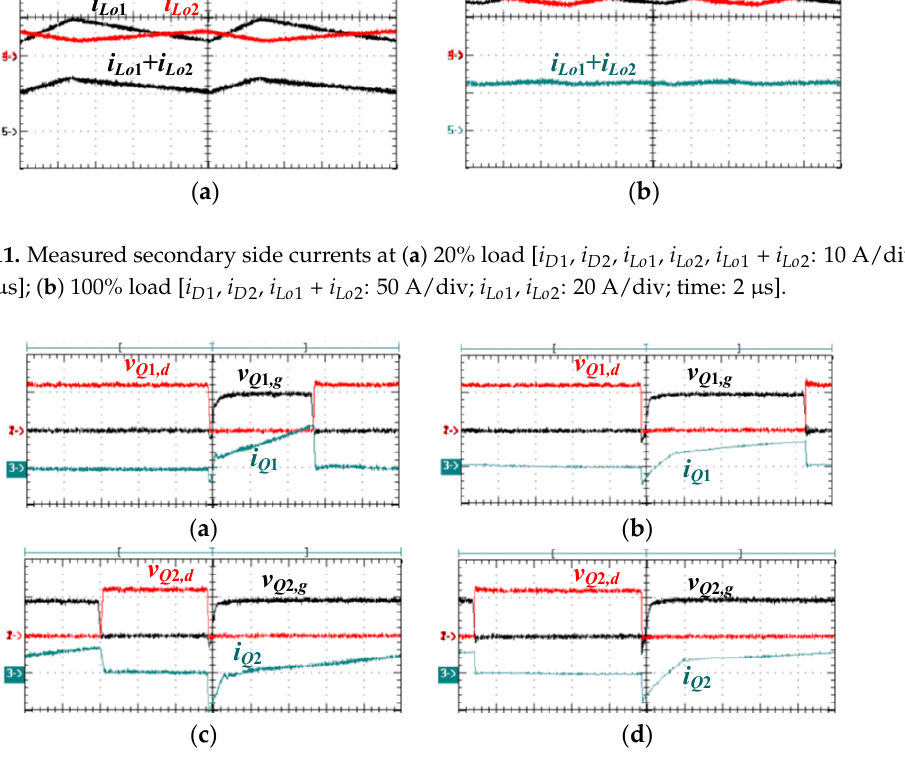
Figure 12. Measured switch voltages and current ( a ) Q 1 at 20% load [ v Q 1 , g : 10 V/div; v Q 1, d : 200 V/div;